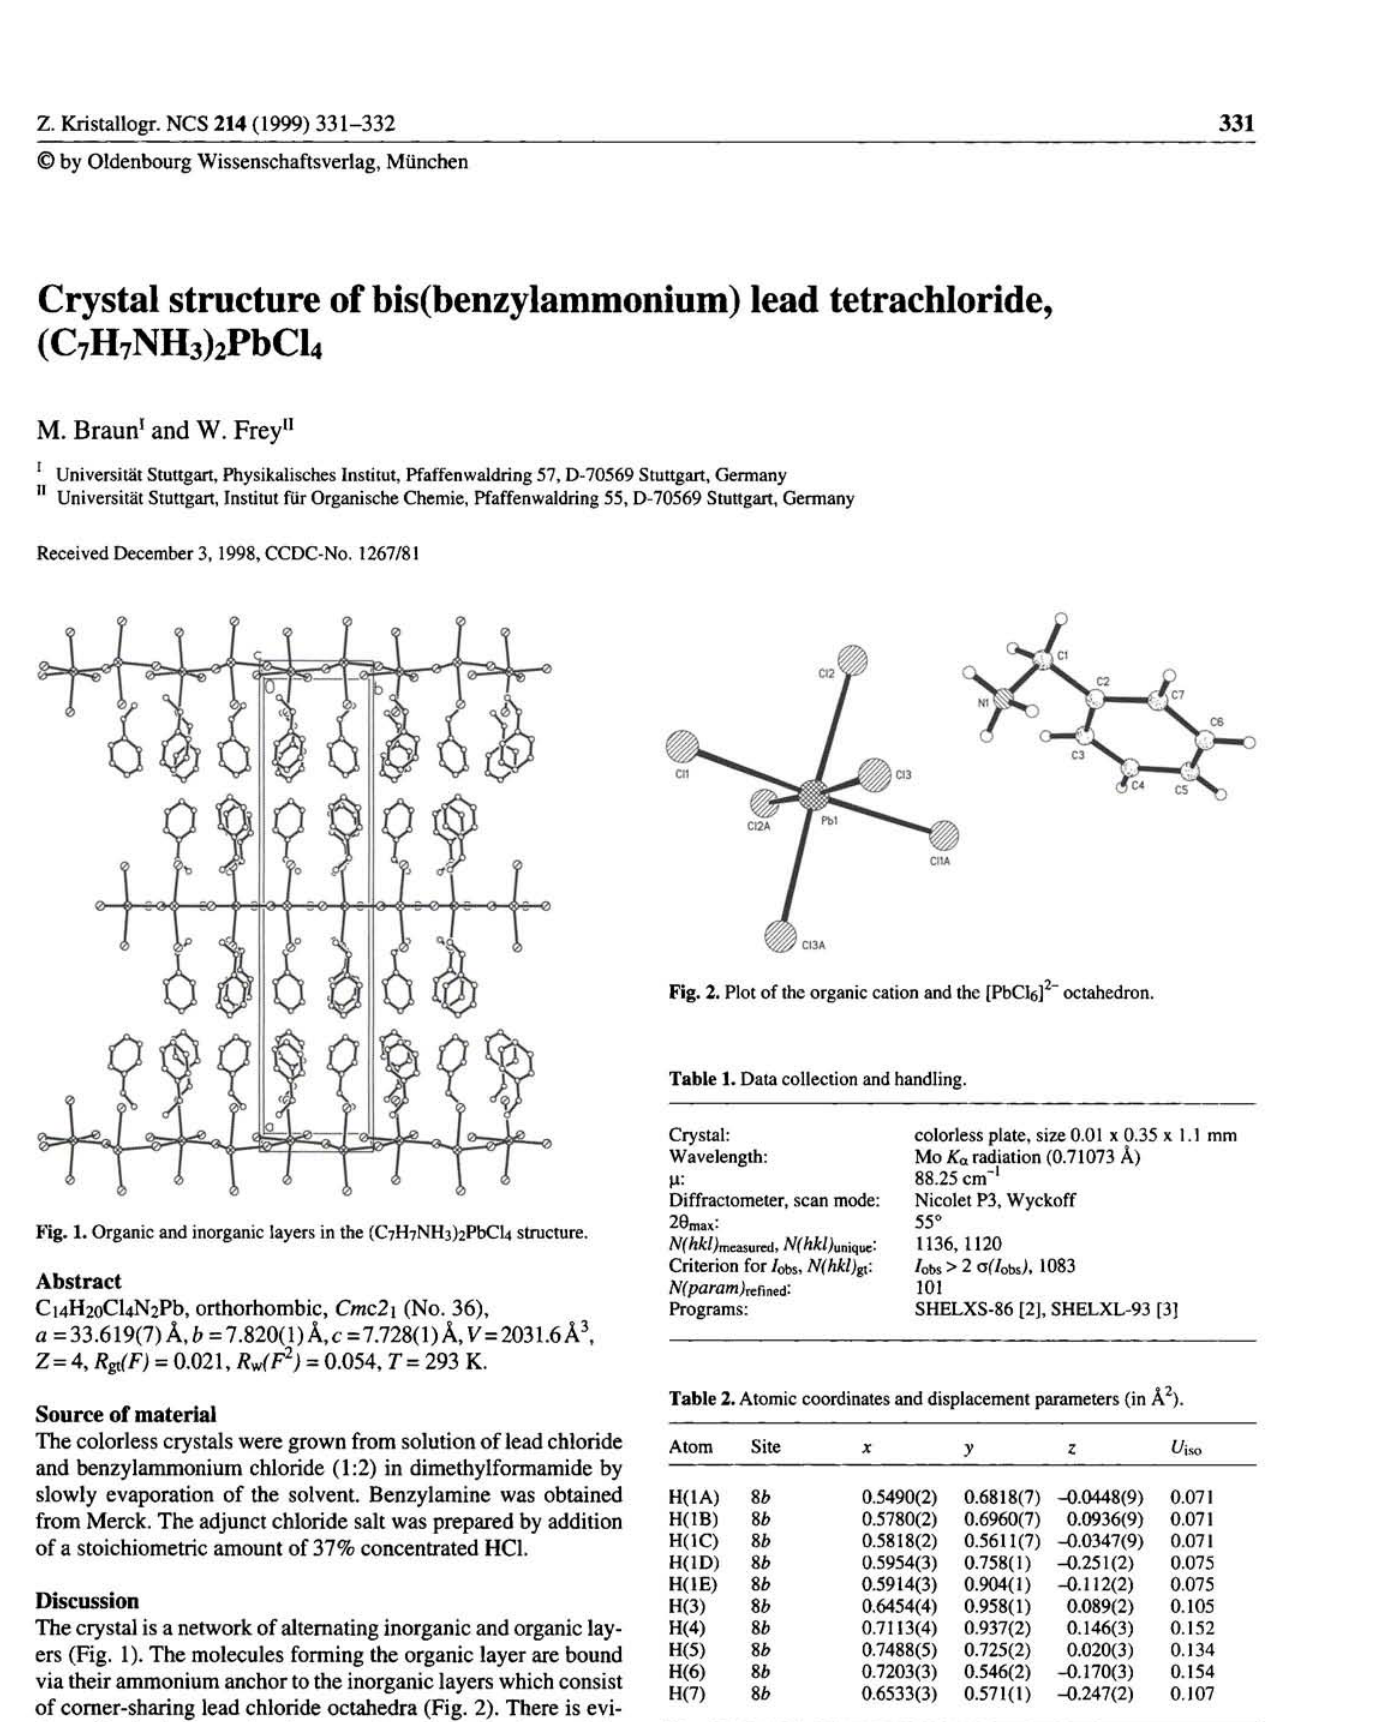
Table 2. Atomic coordinates and displacement parameters (in Â 2